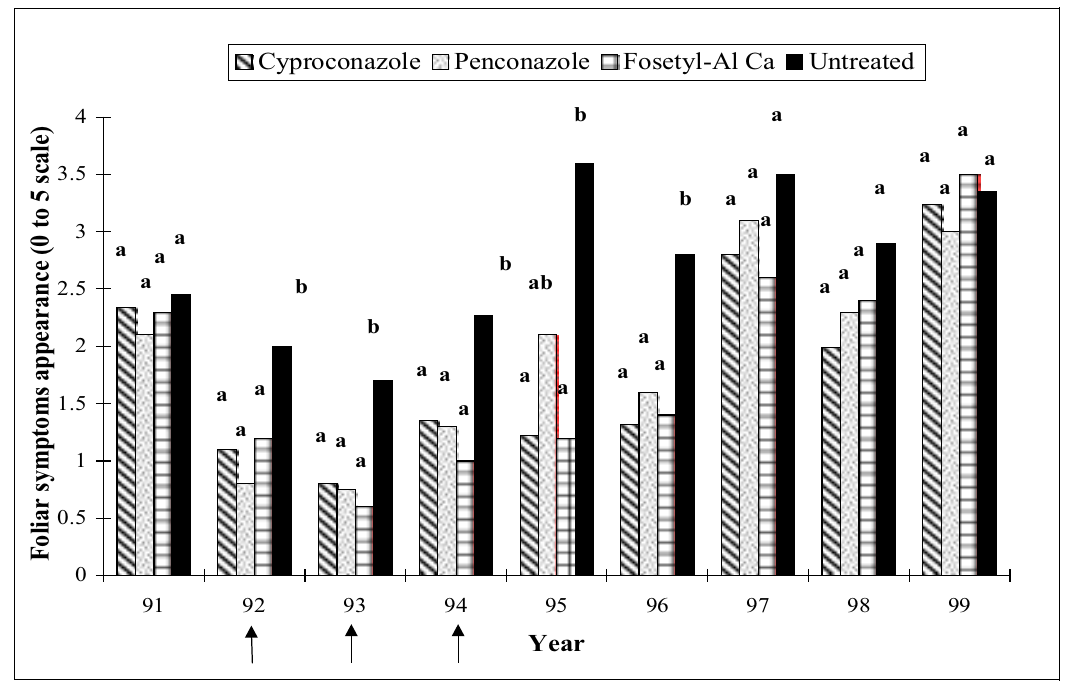
Fig. 4. Syringe field trial (cv. Sangiovese). Black arrow means fungicide application; values marked with the same letter are not statistically different ( P =0.05) according to Duncan’s multiple